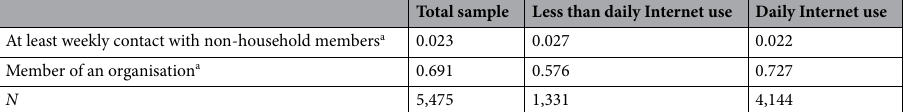
Table 1. Sample pre-COVID-19 characteristics, by reported Internet use in June/July 2020. Figures are averages, weighted using cross-sectional weights provided by the ELSA team. Participants are only included if they provided a response to the item “Since the coronavirus outbreak, on average, how often did you use the internet or email?” in the COVID-19 Substudy. Figures in parentheses are standard deviations of continuous scores. a Supplementary Table S3 presents further information on this factor, including constituting items, scoring, and standardisation